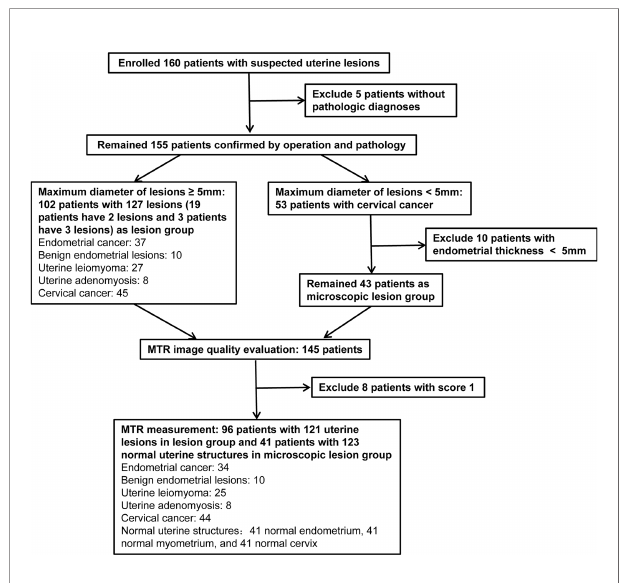
FIGURE 1 | Flowchart of the